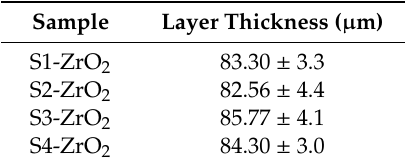
Table 3. Average elemental compositions obtained by energy dispersive X-ray spectroscopy analysis for the coated alloys. Table 4. The thickness of the deposited layers.